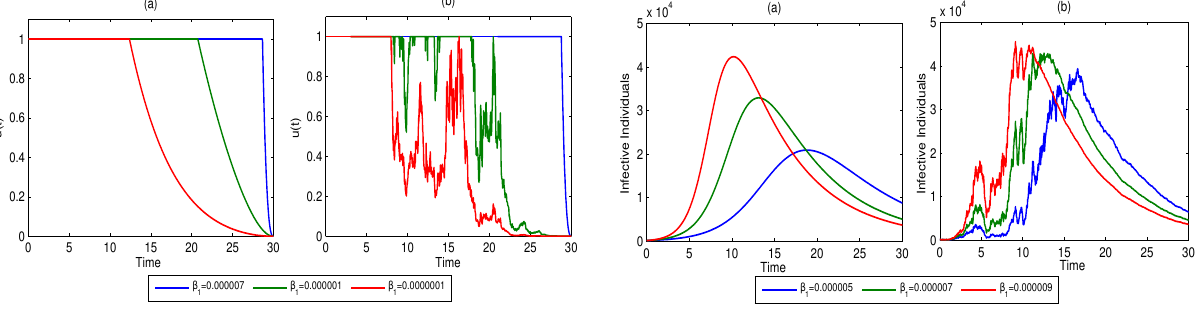
Figure 5. Simulation of Determinis- tic ( a ) and Stochastic ( b ) Infectives for different values of β 1 .